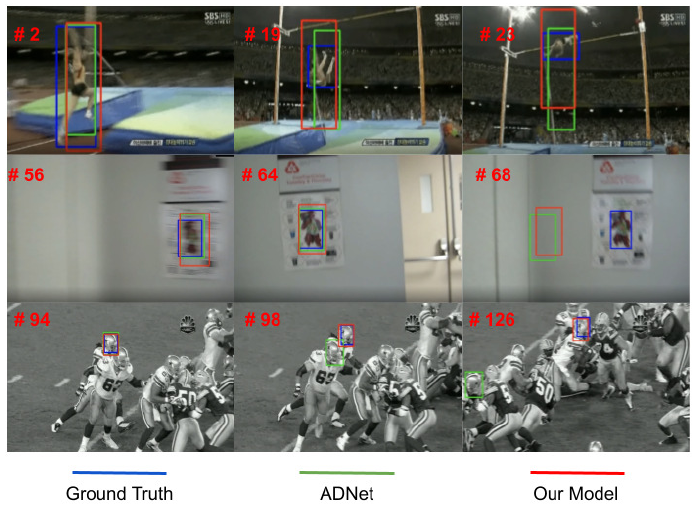
Figure 6. The figure shows some qualitative results of our tracker (red bounding-boxes) vs. ADNet (green bounding-boxes). Ground-truth is shown in